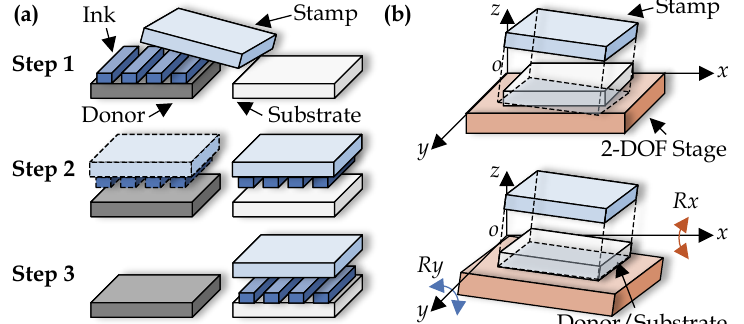
Figure 1. Schematic of transfer printing and potential application of 2-DOF rotation stage in this field. ( a ) Illustration of the operating process of transfer printing. Step 1: some releasable inks are mounted on a donor; Step 2: the inks are retrieved by an elastomer stamp and moved above a substrate; Step 3: the inks are printed onto the substrate. ( b ) Potential application of 2-DOF rotation stage in micro transfer